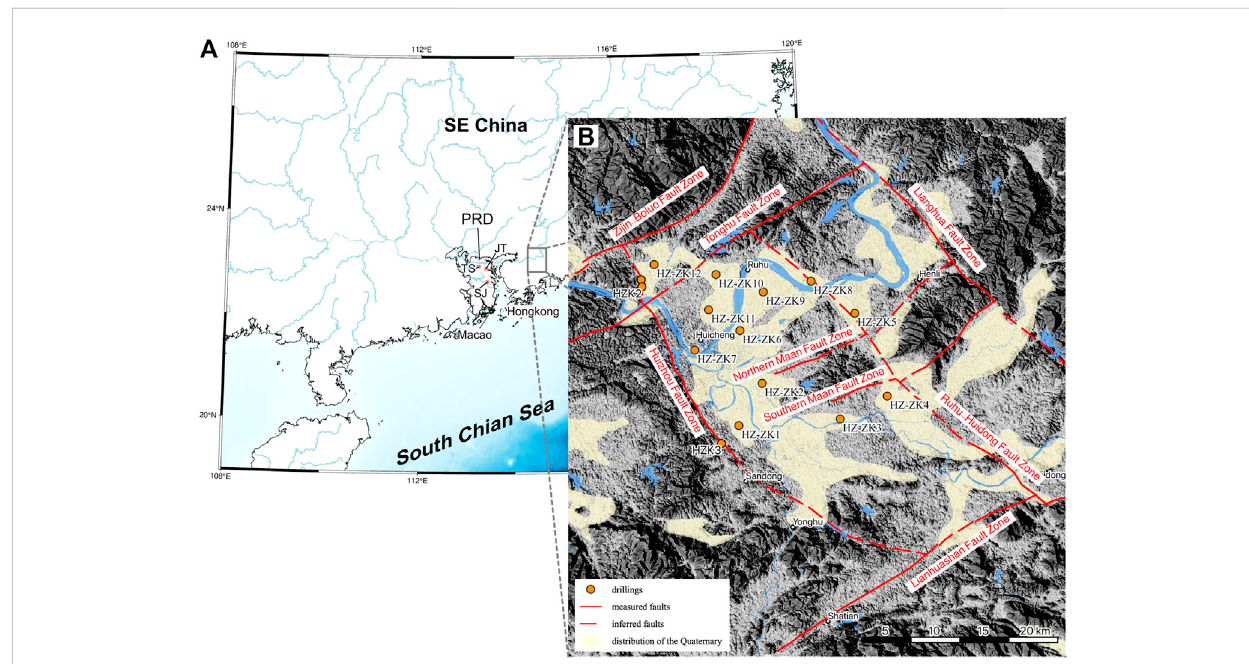
FIGURE 1 Location and tectonic landform map of the Huizhou Basin. (A) The location of the Pearl River Delta PRD and the Huizhou Basin. JT, SJ and TS were thesamplinglocationsofWangetal.(2018b). (B) DistributionoftheQuaternarysediment,regionalbasementfaultsandthelocationsofthedrillingcores.